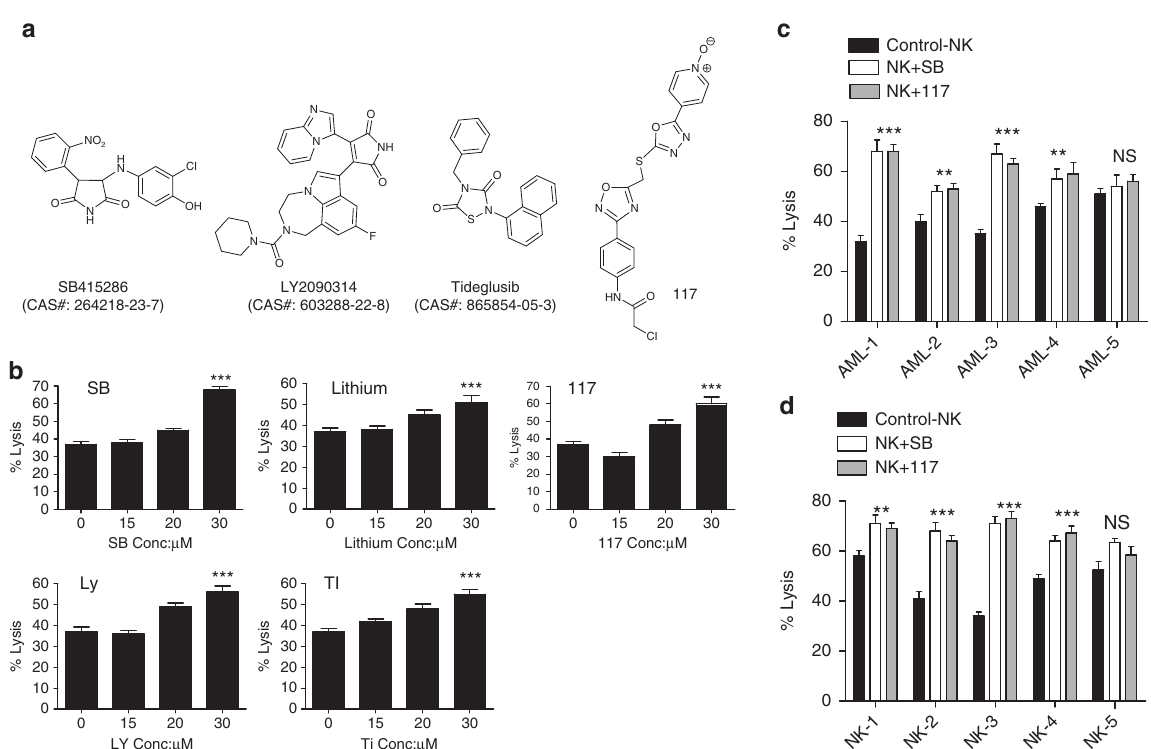
Figure 2 | Structurally distinct GSK3 inhibitors enhance NK cell activity against AML cells. ( a ) Chemical structures of GSK3 inhibitors SB415286, LY-2090314, Tideglusib and compound 117. ( b ) Expanded NK cells isolated from normal donors were pre-treated with vehicle or the indicated concentrations of the GSK3 inhibitors for 16h. The NK cells were then incubated with OCI-AML3 cells and the calcein-AM assay was performed after 4h. ( c ) Expanded NK cells were pre-treated with vehicle, SB, or compound 117 for 16h, incubated with primary AML patient leukaemic cells and the calcein-AM assay was performed. ( d ) NK cells from three normal donors were expanded, pre-treated with vehicle, compound 117 or SB for 16h. The cells were incubated for 4h with OCI-AML3 cells and lysis was measured using the calcein-AM assay. (unpaired Student’s t -test *** P o 0.001, ** P o